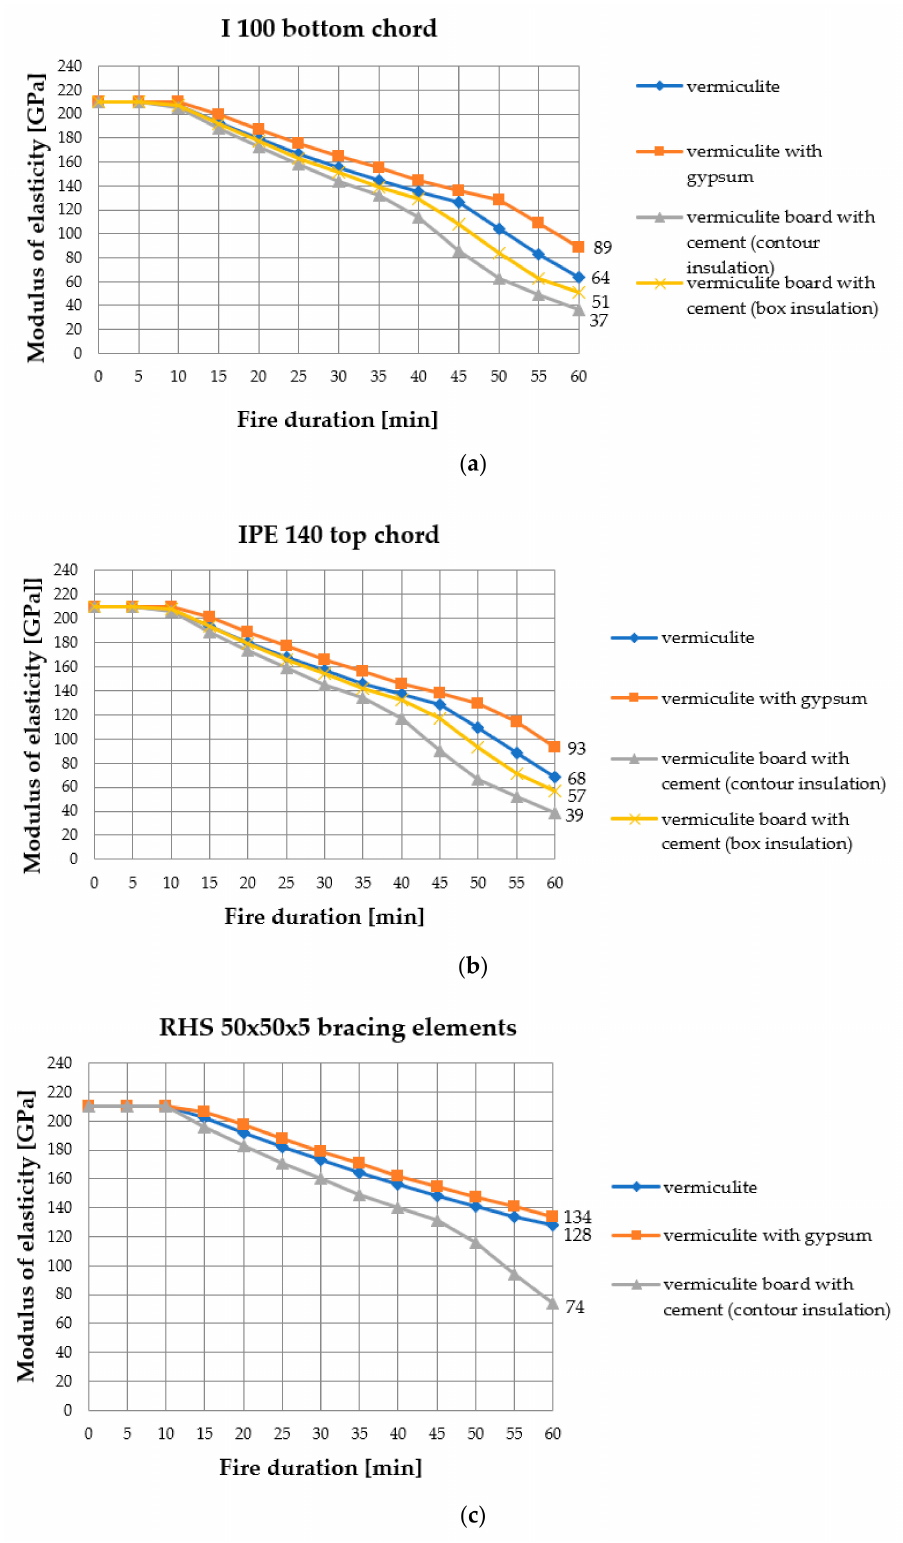
Figure 4. Decrease in modulus of elasticity under fire conditions (insulation 2 cm): ( a ) I 100 bottom chord, ( b ) IPE 140 top chord, ( c ) RHS 50X50X5 bracing